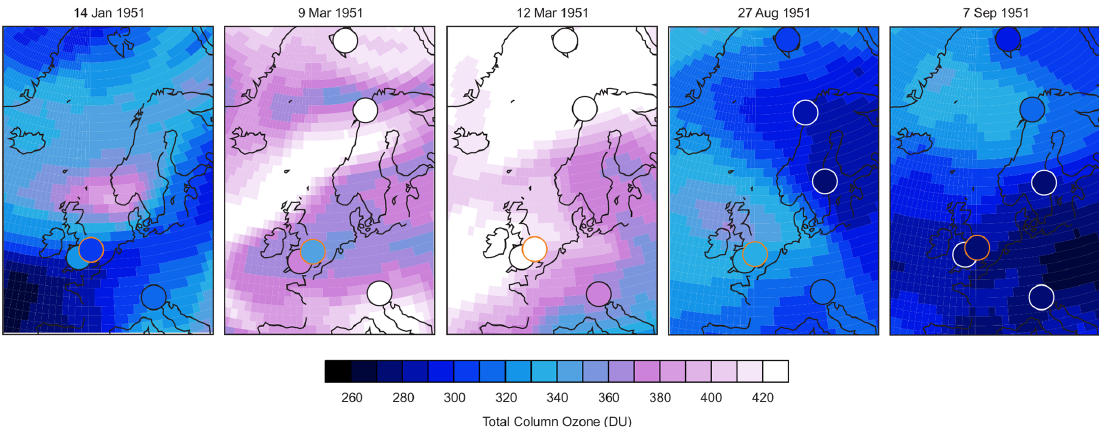
Figure 9. Total column ozone in ERA-PreSAT as well as in observations from various stations on five days in the year 1951 (Downham Market is marked with an orange outline of a